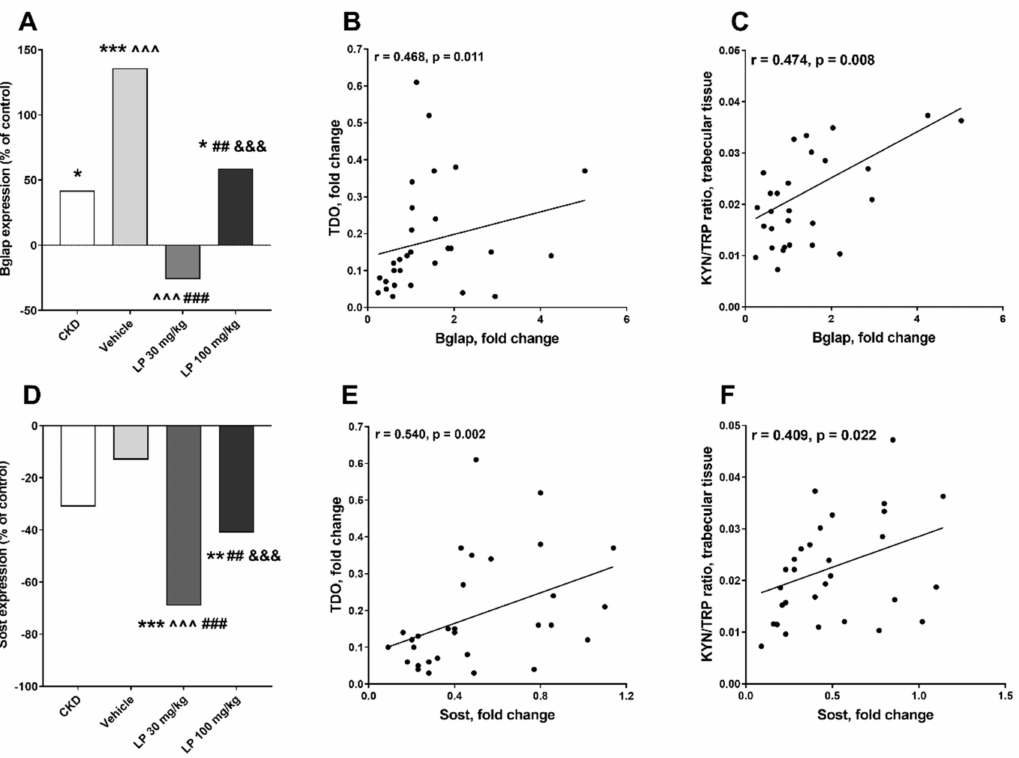
Figure 7. Changes in osteocalcin (Bglap) and (sclerostin) Sost gene expression among experimental groups ( A , D ), and their associations with tryptophan 2,3-dioxygenase (TDO) expression ( B , E ), and kynurenine to tryptophan (KYN / TRP) ratio in trabecular bone tissue ( C , F ) in rats with CKD treated with LP533401. Data relate to the control taken as 0%. * p < 0.05, ** p < 0.01, *** p < 0.001, control vs. others; ˆˆˆ p < 0.001, CKD vs. others; ## p < 0.01, ### p < 0.001, vehicle vs. others; &&& p < 0.001, LP 30 mg / kg vs. LP 100 mg /